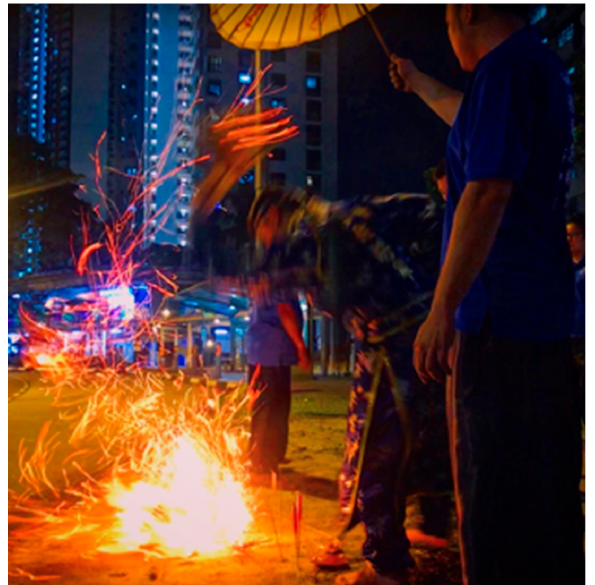
Figure 2. O ff erings Set Up by the Roadside for “Hungry Ghosts” during a Yewkeng around the HDB Estate. This photo was taken near a bus stop where Xie Jiang Jun (in a blue-colored robe patterned with gold-colored leaves) stopped to instruct his temple assistants to set up a small set of o ff erings. A stack of joss paper was then set alight as a form of o ff ering to the wandering spirits of the Hungry Ghost